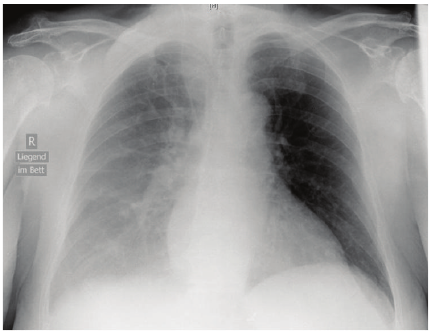
Figure 2: Chest X-ray anteroposterior after puncture